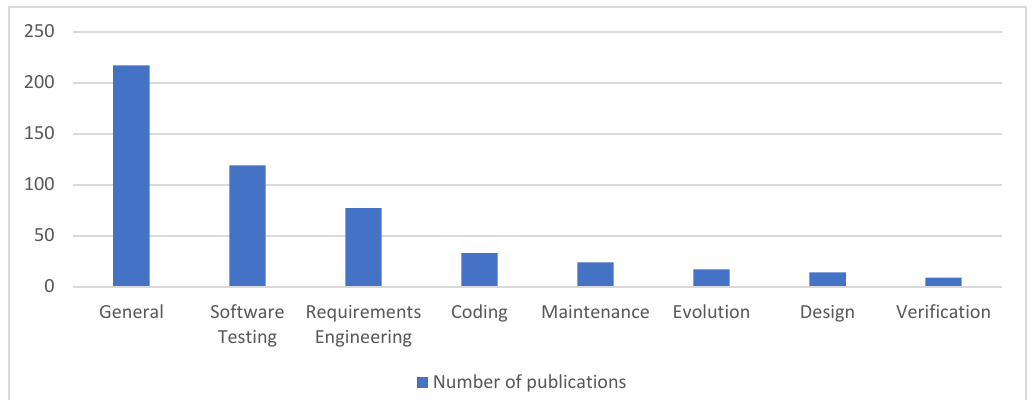
Figure 16. Clustering of citation networks based on publication category.